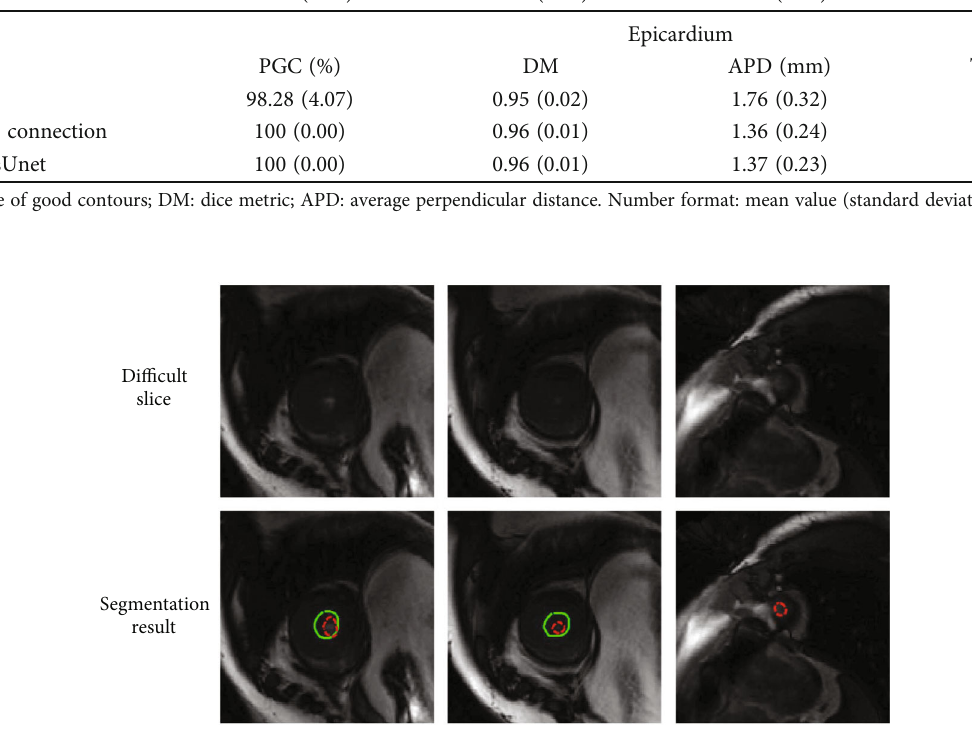
Figure 8: Segmentation results (solid green line) and ground truth (dotted red line) of three di ffi cult (solid green line) and ground truth (dotted red line). From left to right are the slices IM-0001-0127 in SC-HYP-37,